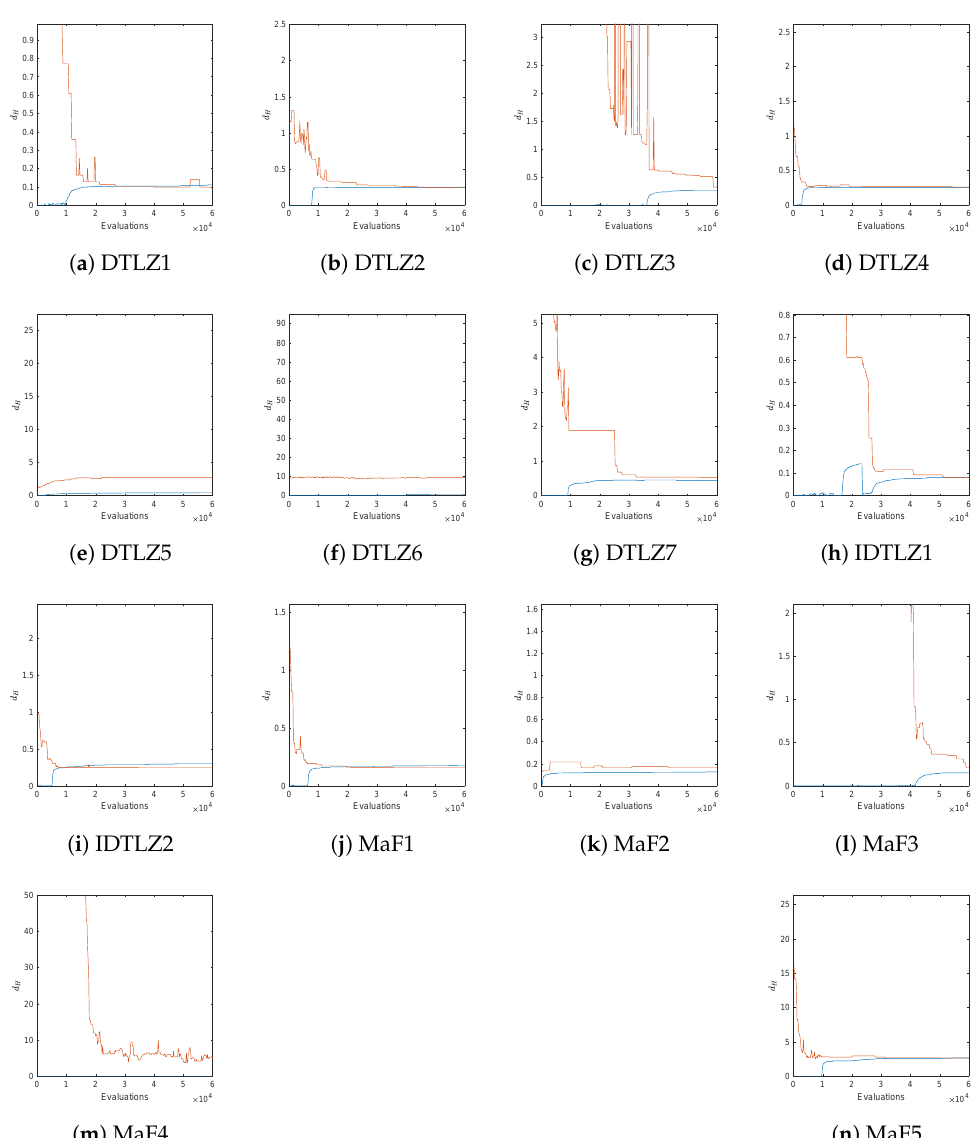
Figure A9. Evolution of the Hausdorff distances d H ( F ( A ) , F ( P Q )) of NSGA-II-A and the computed approximations ∆ for several test functions, using k = 5